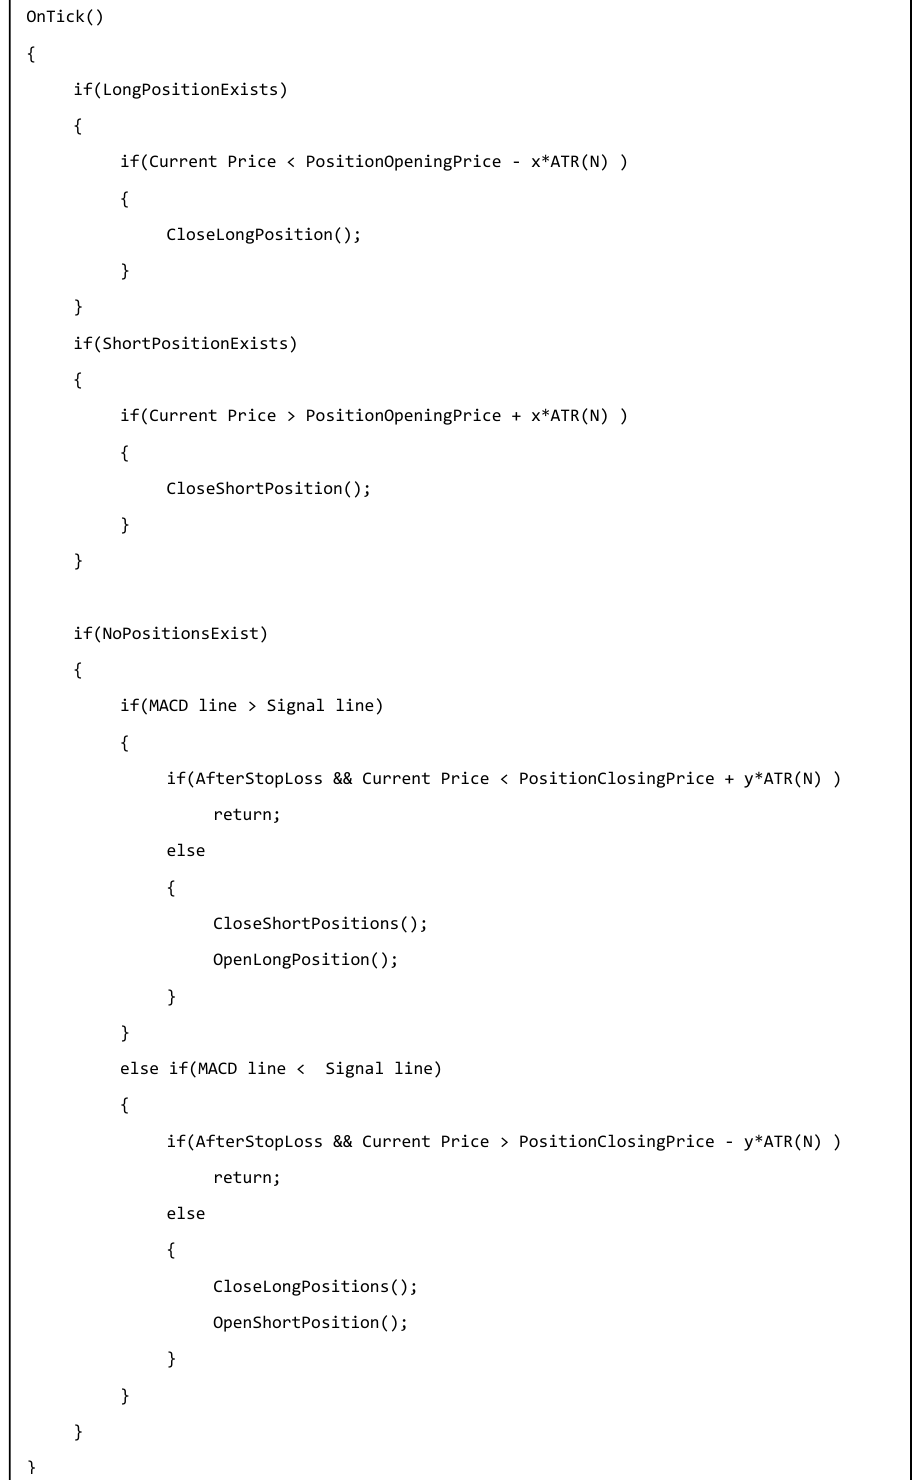
Pseudocode of the MACD trading strategy with a constant ATR Stop Loss barrier zone, as described in Section 2.3.5.